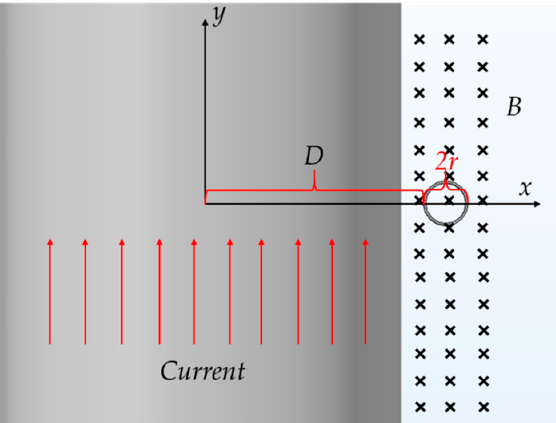
Figure 6. Induced voltage calculation in calibration environment. The current flows along the aluminum barrel, and the resulting magnetic field points in-plane along the tangent of the aluminum barrel, inducing an electromotive force in the B-dot.